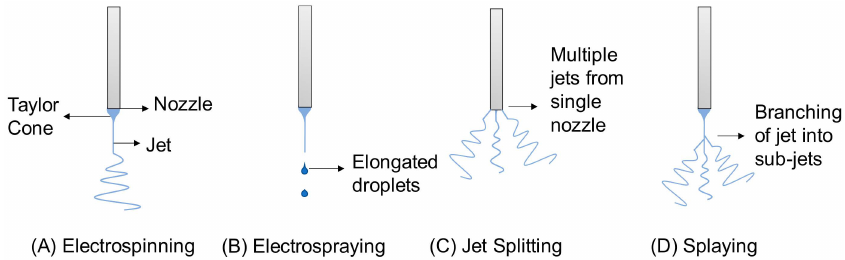
Figure 2. Schematic illustration of the behavior of jets during the electrospinning